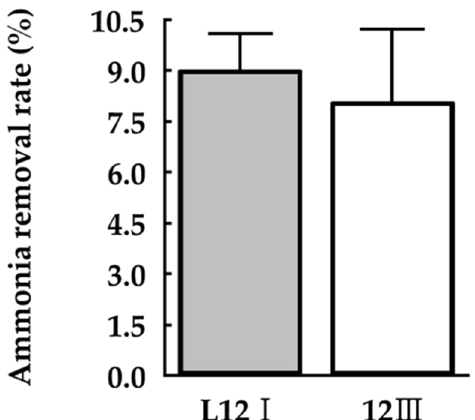
Figure 5. Ammonia removal rate of selected bacterial strains in the minimal medium by using indophenol method. Values represent the mean ± S.E. ( n = 3).